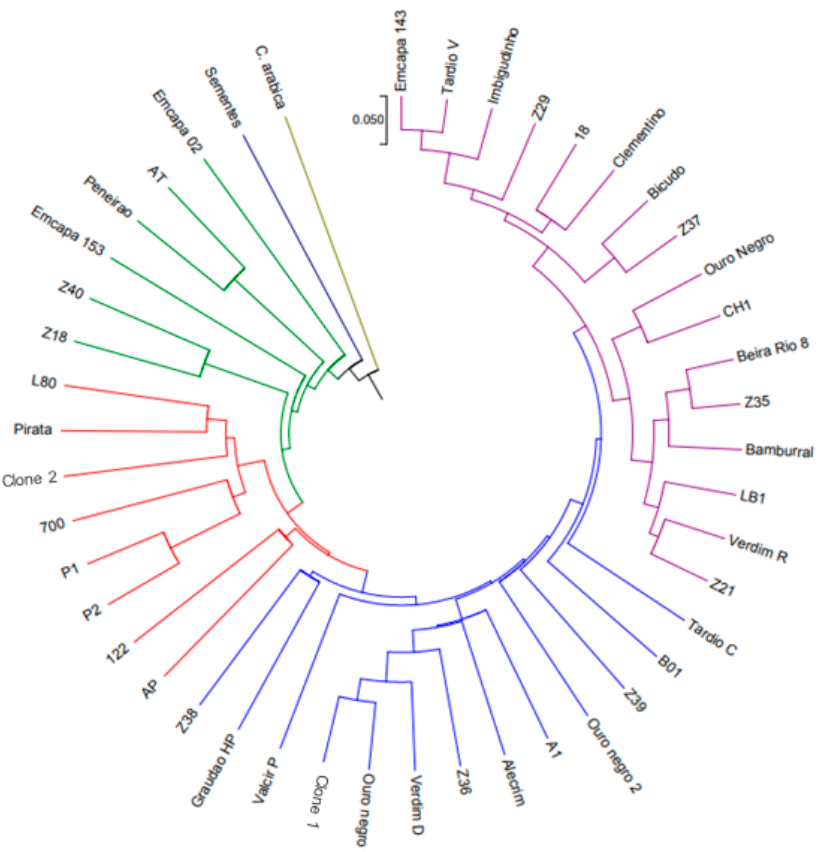
Figure 2. Dendrogram of genetic dissimilarity among 44 Coffea canephora genotypes and 1 Coffea arabica genotype, constructed using the UPGMA method, with SSR and EST markers.